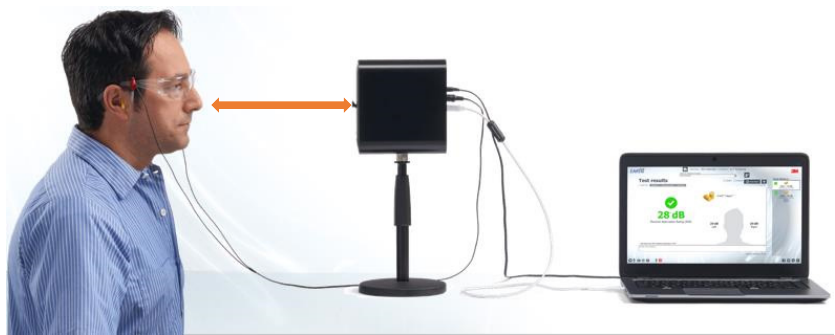
Figure 4. An example where the test result of the PAR value was “fail” in the first test in the Figure 4. The distance from the testee’s nose to the clip on the loudspeaker was 40 Figure 6. The distance from the testee’s nose to the clip on the loudspeaker was 40 cm. untaught situation of the testee.